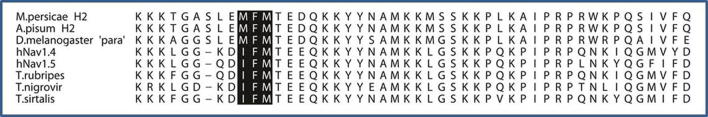
Alignment of the domain III–IV interconnecting loop region of Nav channels. The inactivation particle (M/I) FM motifs in DI (H2 of aphids) and DIII (other species) are highlighted.